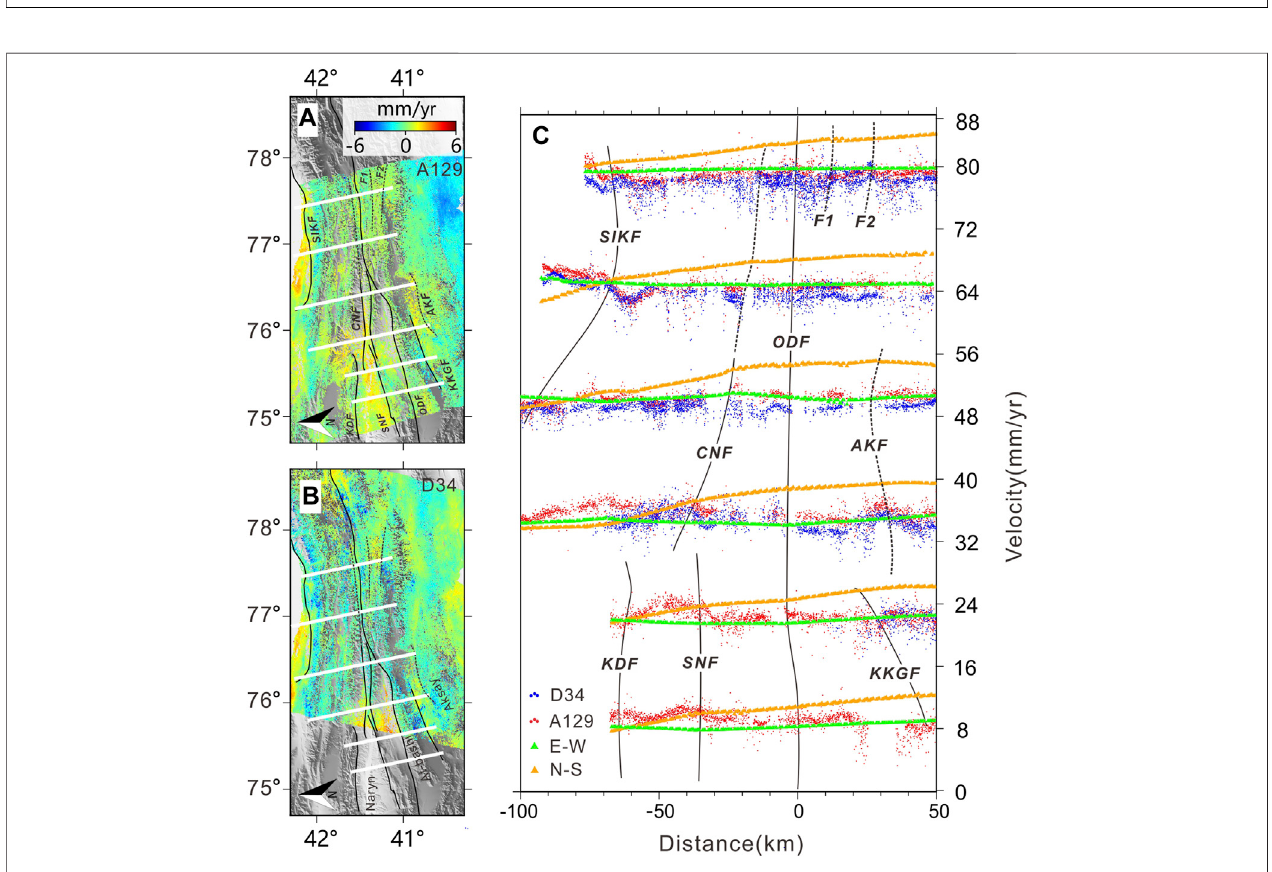
FIGURE 7 | Deformation data pro fi le across the north of the South Tianshan. (A,B) indicate LOS velocity map of the tracks 129 (A129) and 34 (D34),respectively. The whitelines are 6pro fi les locations (C) velocity pro fi le from D34 (bluedots), A129(red dots),E-W (green triangle)andN-S (yellow triangle). KKGF, kerkeigelfault;AKF, Aksay fault; ODF, Oinak-Djar fault; SNF, South Naryn fault; KDF, Kadierty fault; CNF, Central Naryn fault; SIKF, South Issyk-Kul lake fault.